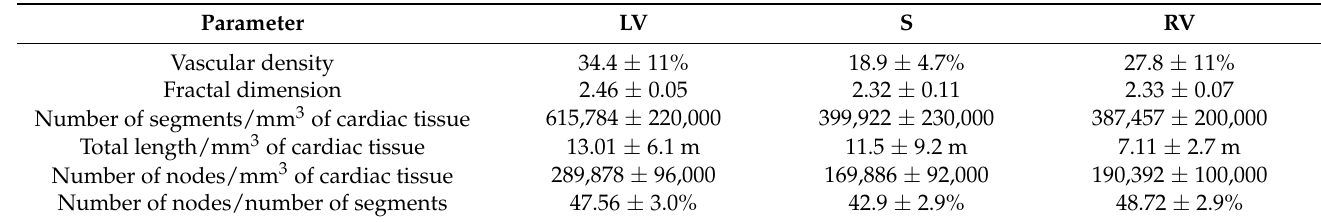
Table 3. Global parameters. Values were calculated from left ventricle (LV), septum (S), and right ventricle (RV) of six mouse